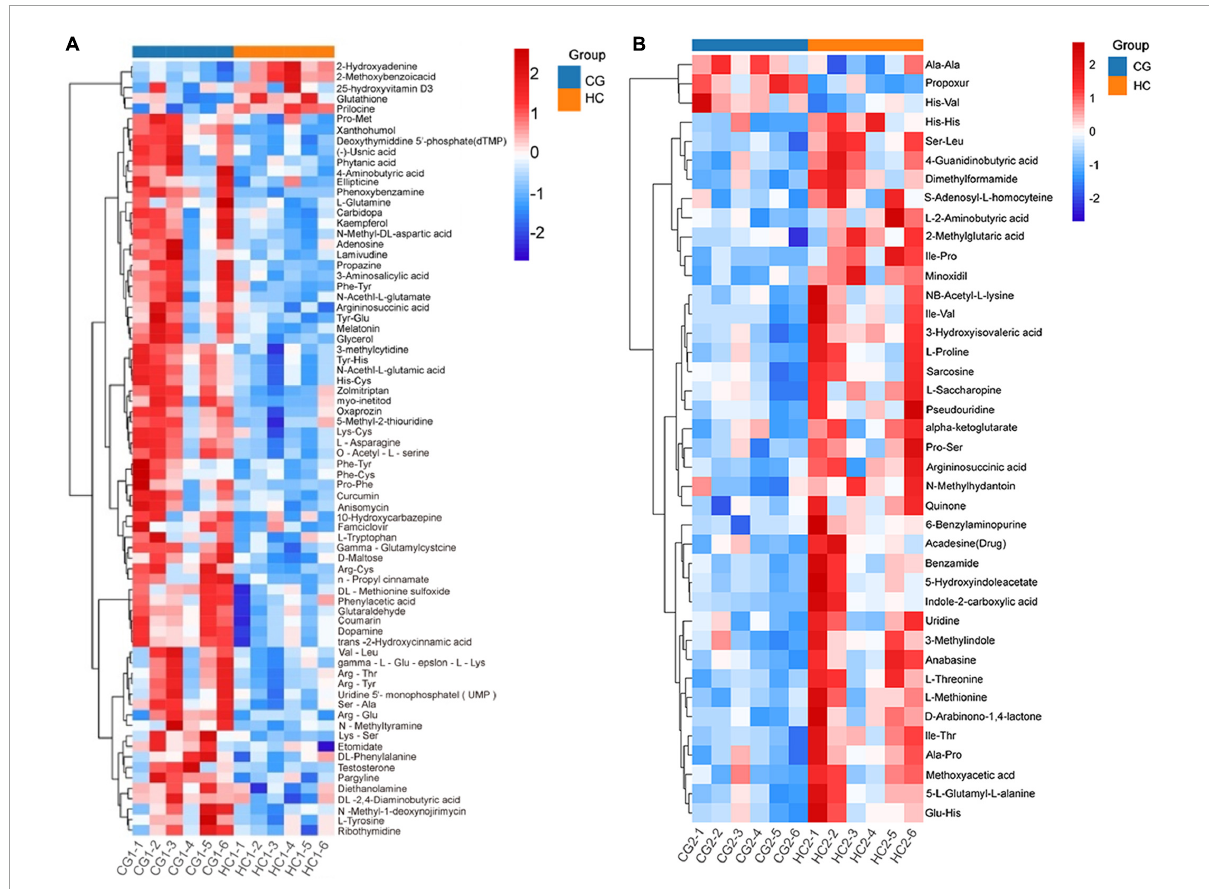
FIGURE5 Hierarchical clustering analysis for plasma metabolites in Ira rabbits in the high dose at 53 days of age (A) and 67 days of age (B) . Each column in the figure represents a